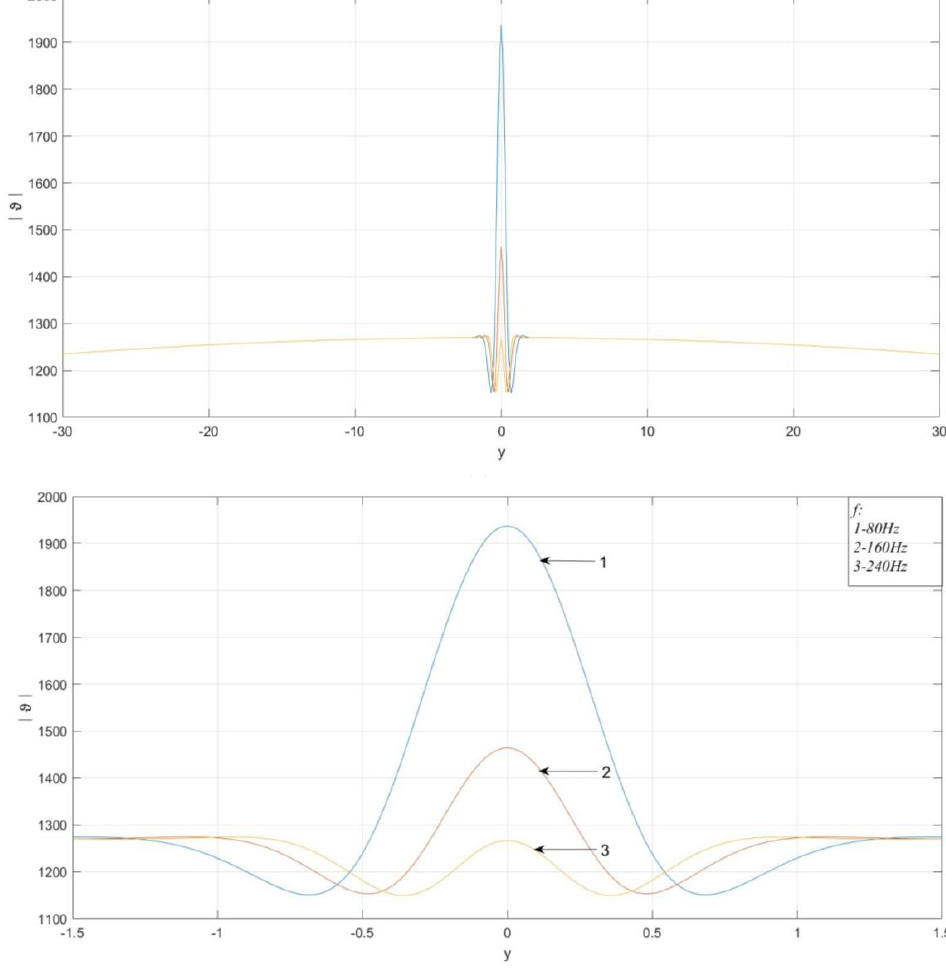
Figure 2. ( a ) Temperature near the circular opening of Pt–Rh GFLP, ( b ). Temperature near the circular opening of Pt–Rh GFLP. Figure 3 correspond to the position of the circular opening along the transversal direction of the leaky plate, that is, the y -direction: distance from the upper boundary is taken c 1 = 200mm, distance from the lower boundary is taken c 2 = 200mm; The laser pulse frequency is taken f = 80 Hz; The mass fraction of rhodium element in Pt–Rh GFLP is taken 5% and 10% respectively. Figure 3a shows the distribution of temperature in the section y ∈ (−30 mm, 30 mm) with the center of the circular opening as the origin, and Figure 3b shows the distribution of temperature in the section y ∈ (−1.5 mm, 1.5 mm) with the center of the circular opening as the origin. From the consistent change trend of the two temperature distribution curves, it can be found that the temperature peaks at y = 0 position, and the temperature starts to increase suddenly in the section of y ∈ (−0.7 mm, 0.7 mm), the temperature gradually decreases with the increase of the distance from y = 0 position, and the temperature distribution is symmetrical along the line y = 0. From the comparison of the differences in the three temperature distribution curves, as the laser pulse frequency increases, the peak temperature gradually decreases, and the length of section where the temperature suddenly increases gradually decreases; In the section other than y ∈ (−1.5 mm, 1.5 mm), the laser pulse frequency has no obvious influence on the distribution of temperature. (a)